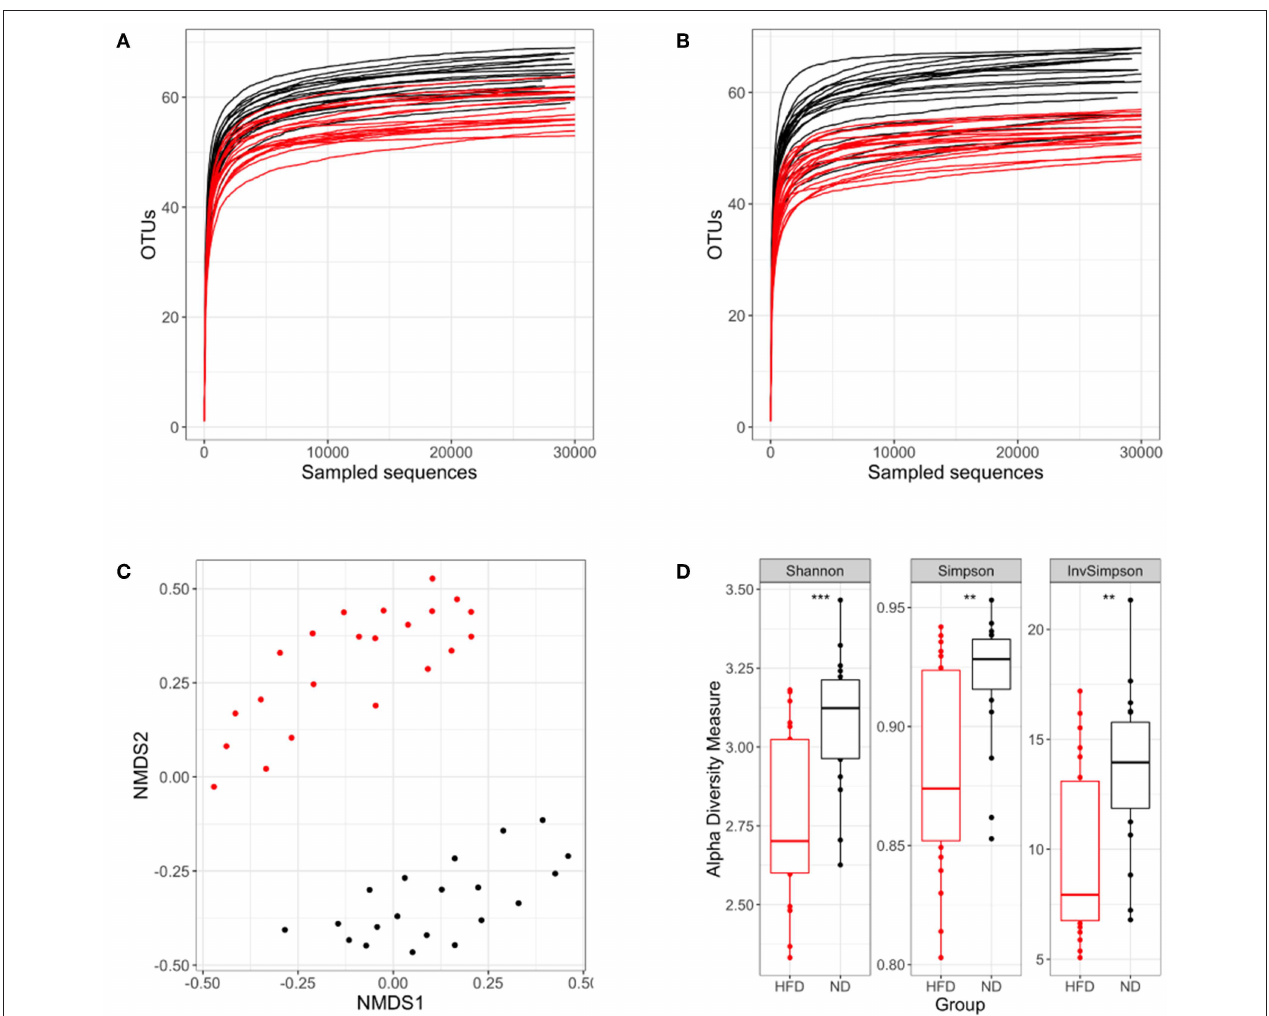
FIGURE 8 | Analysis of the microbiota diversity based on 16S rRNA sequencing. In each panel the ND group is colored in black and the HFD group in red. Rarefaction curves at week 16 (A) and week 28 (B) after starting the different diets are represented. (C) NMDS ordination in samples following different diets. (D) Shannon, Simpson and inverse Simpson diversity indexes. ** p < 0.01, *** p < 0.001; Mann–Whitney